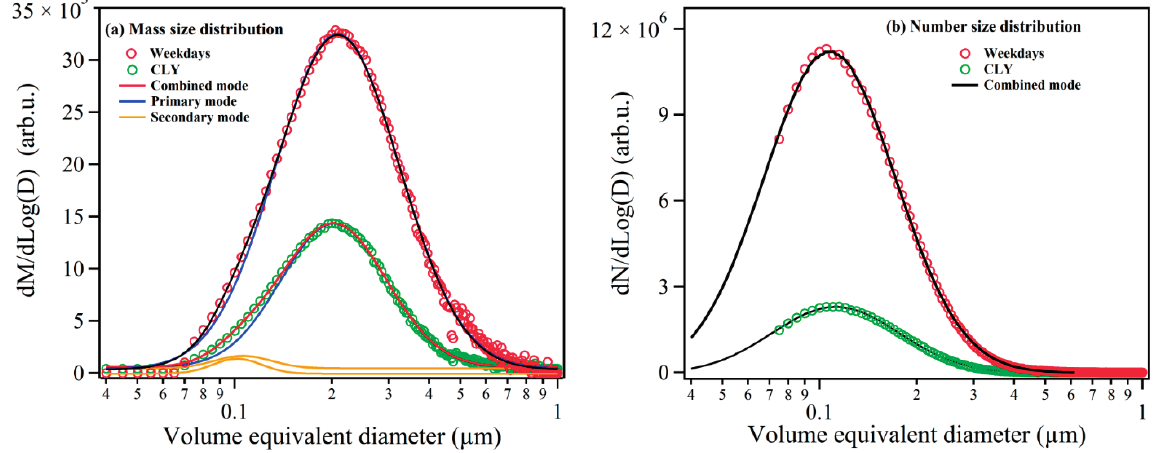
Figure 5. ( a ) Mass and ( b ) number size distributions of rBC for the Chinese Lunar Year (CLY) and on weekdays. A two-mode lognormal function fits the data of mass size distribution, while a single-mode lognormal function fits the data of number size distribution. “M” and “D” in the vertical labels represent rBC mass and diameter,